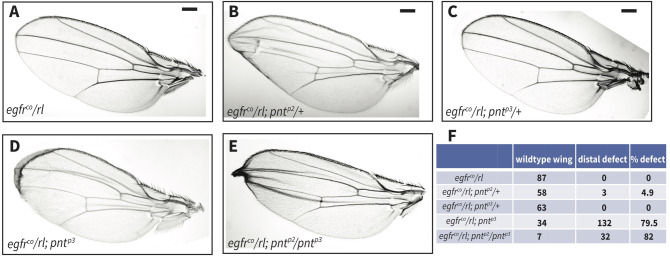
PntP2 and PntP3 buffer against the reduction of MAPK activation during wing patterning.(A-E) Representative adult wings, oriented anterior up and distal left, showing the effects of reduced pntp2 and pntp3 dose in a sensitized egfrco
/rl background. (A) egfrco/rl trans-heterozygotes appeared wild type. (B) Loss of one copy of pntp2 produced occasional distal margin defects. (C) Loss of one copy of pntp3 did not disrupt patterning. (D) Loss of both copies of pntp3 resulted in penetrant distal margin defects. (E) Simultaneous reduction in dose of pntp2 and pntp3 synergistically increased wing margin defects. (F) Quantification of wings as either wild type or with margin defects for each genotype in (A-E). Scale bar: 0.1 mm.